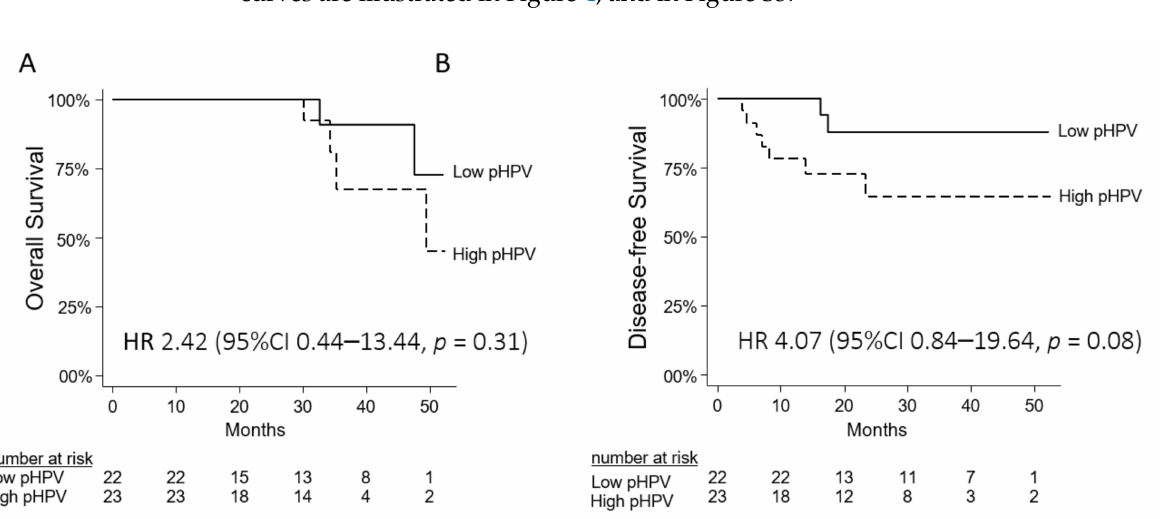
Figure 4. Kaplan–Meier curves for overall survival ( A ) and disease-free survival ( B ) for 45 patients according to high and low pHPV status prior to treatment (cut-off median pHPV of